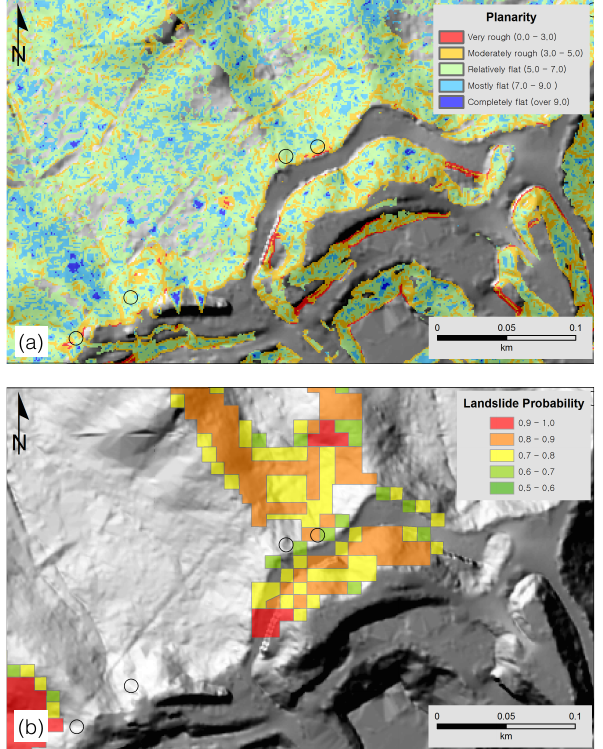
Figure 14. Evaluation of the planarity compared with the multi- variate statistic carried out by Yoo et al. (2014). (a) Distribution of the planarity. The designated area is delineated in Fig. 10b. (b) The landslide hazard assessment is based on the logistic regres- sion